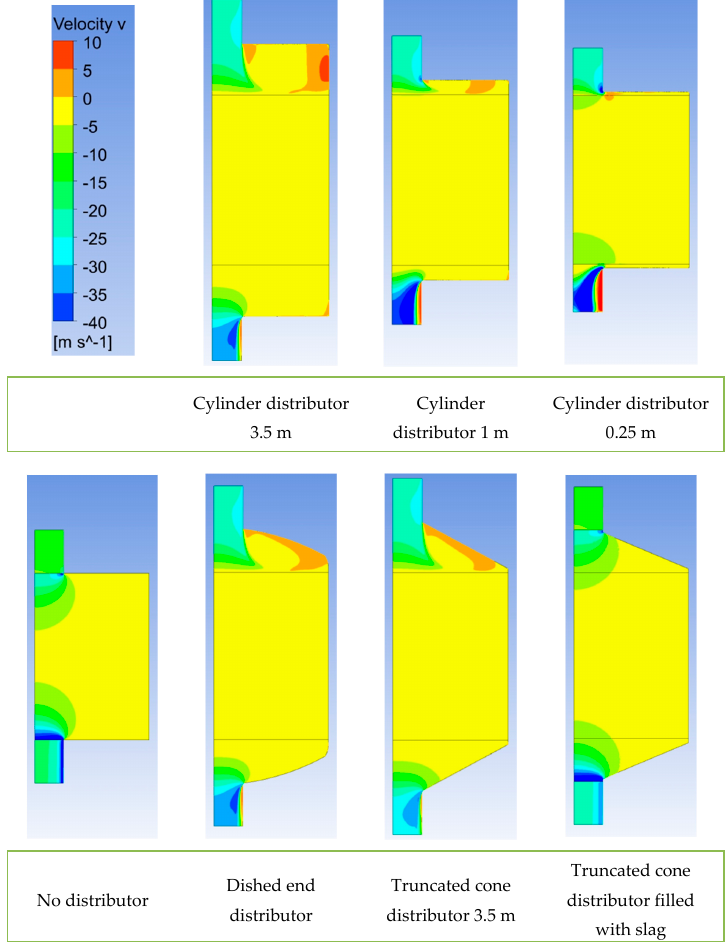
Figure 10. Contour plots for seven different design options for the distributor. Case “Charging, full load”.